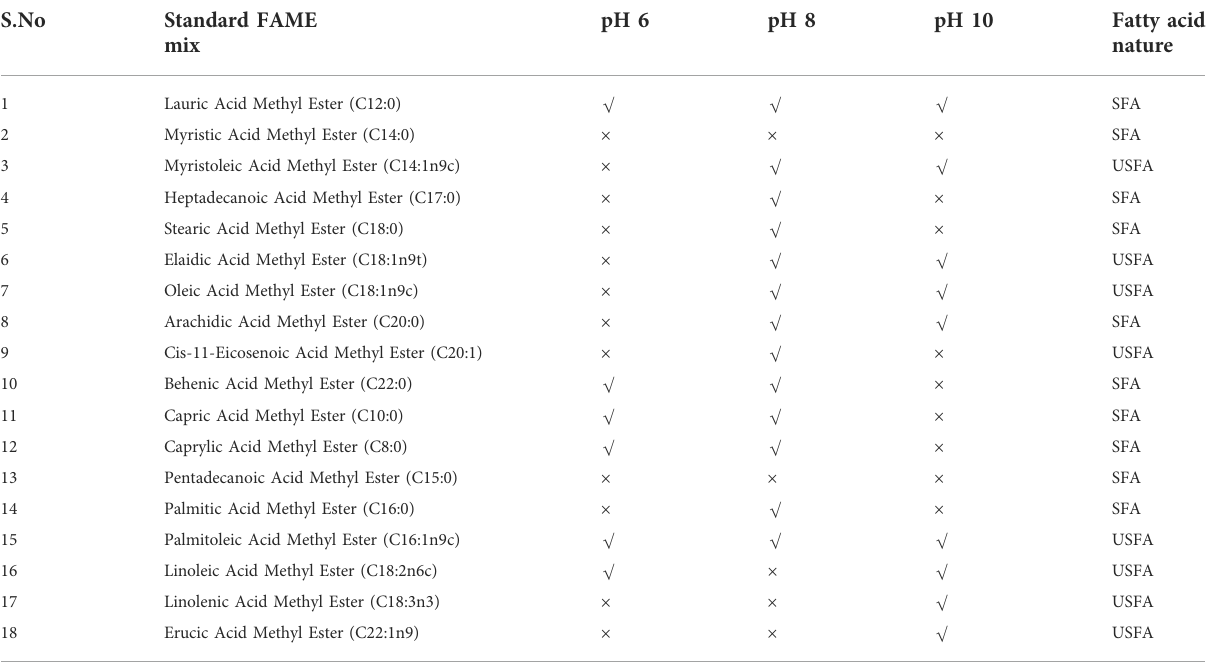
TABLE 1 GC analysis for FAME composition at operating conditions.